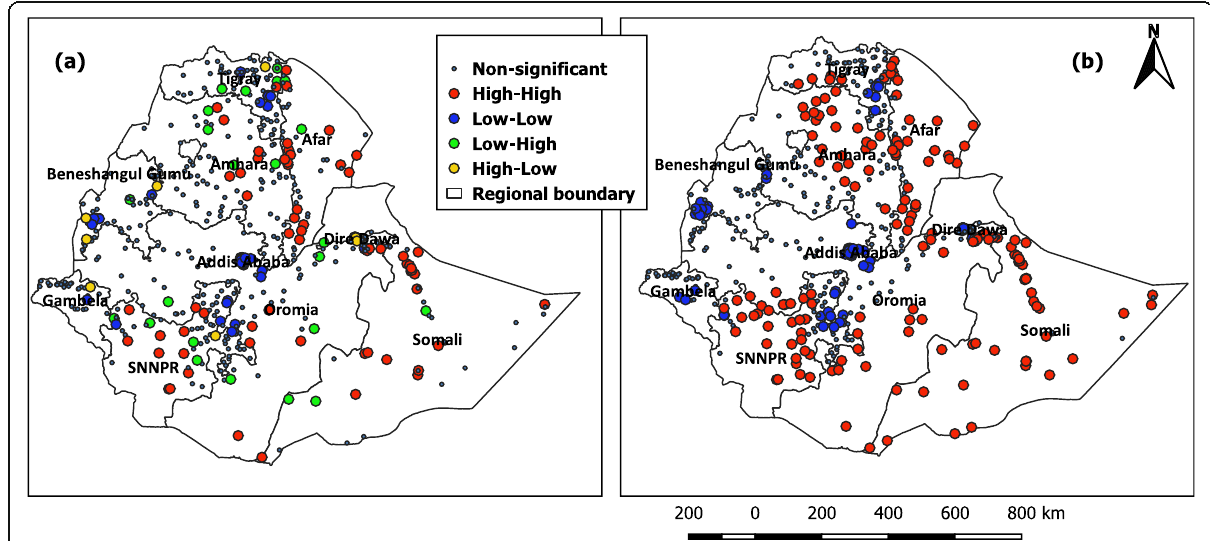
Fig. 6 Clustering trends of coverage rates before ( a ) and after spatial smoothing ( b ). Clustering of spatial outliers was eliminated in the spatially smoothed coverage. The red colors indicate clusters with the highest percentage of unimproved water while the blue colors show clusters with low unimproved water